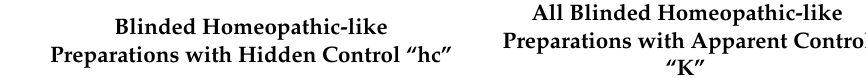
Table 4. Frequencies of occurrence of significant spectral distinctions of homeopathic-like preparations with the hidden control “hc” and the apparent control “K” and significance of differences in the